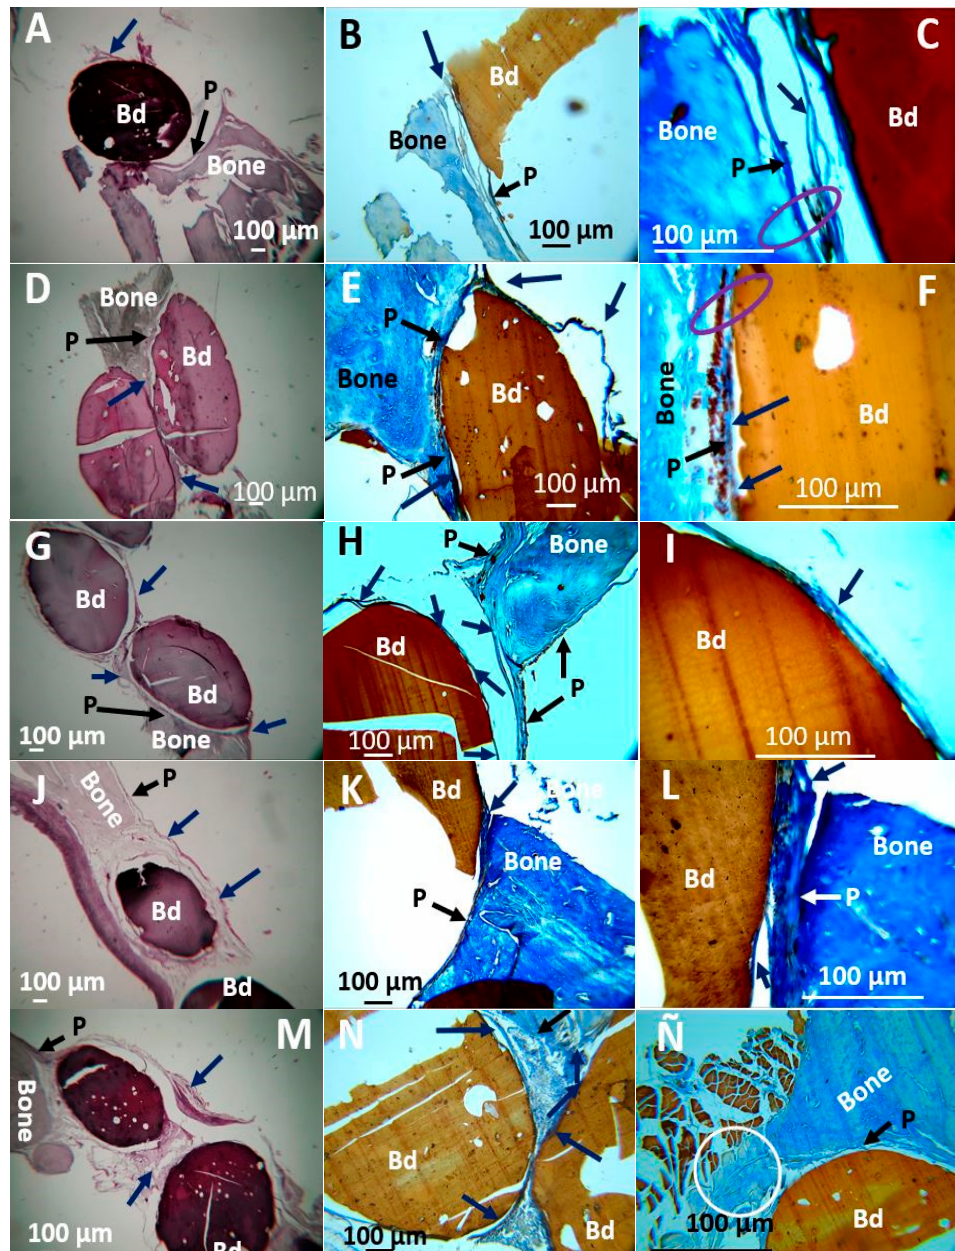
Figure 5. Samples implanted in the cranial bone defect. ( A – C ): F1. ( D – F ): F2. ( G – I ): F3. ( J – L ): F4. ( M – Ñ ): F5. ( A , D , G , J , K ) at 4 × H-E technique. ( B , E , H , K , N ) at 10 × MT technique. ( C , F , I , L , Ñ ) at 40 × MT technique. Bd: Bead. Black arrow P: Periosteum. Blue arrow: Soft tissue that covers the beads. Purple Oval: Areas where there is continuity of bone-bead soft tissue. White Circle: area of new bone formation.